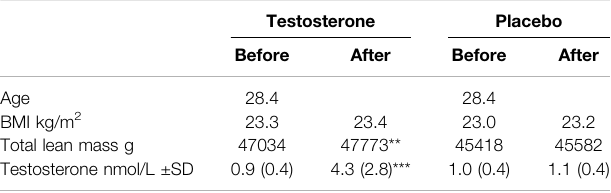
TABLE 1 | Clinical characteristics of the women in the testosterone group and the placebo group before and after treatment. Testosterone Placebo